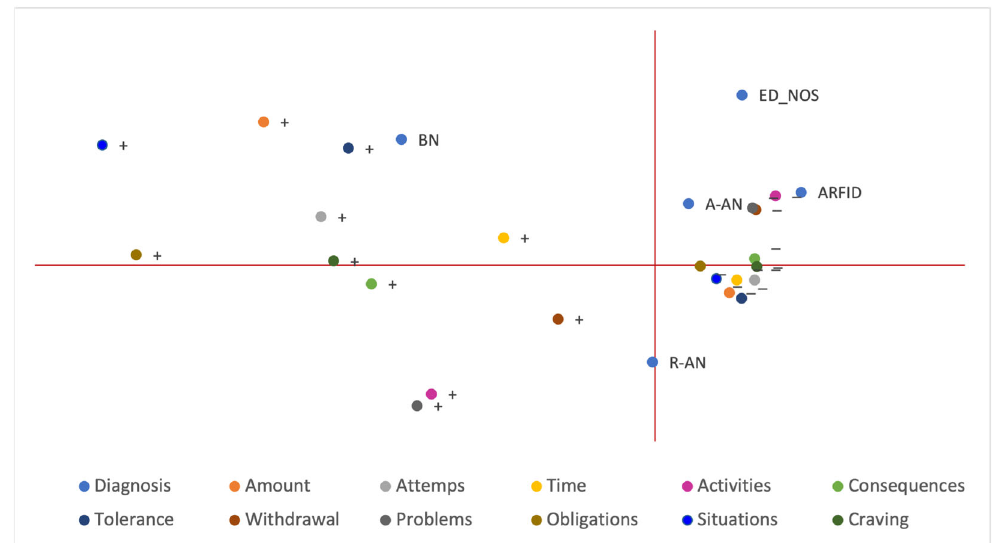
Figure 1. Multiple correspondence analysis between FA symptoms and ED diagnosis. As only one patient was diagnosed with binge eating disorder and one with binge purging ‐ anorexia nervosa, these subgroups were excluded from the MCA analysis due to an insufficient number of patients. + and–correspond to positivity and negativity to FA symptoms, respectively. A ‐ AN, atypical anorexia nervosa; ARFID, avoidant restrictive food intake disorder; BN, bulimia nervosa; ED ‐ NOS, eating disorder not otherwise specified; EDs, eating disorders, R ‐ AN, restrictive anorexia nervosa. ARFID and A ‐ AN diagnoses shared the same profile of negativity to FA symptoms, in particular to “activities”, “problems”, and “withdrawal”. In addition, the ED ‐ NOS pa ‐ tients’ results were close to this type of profile.